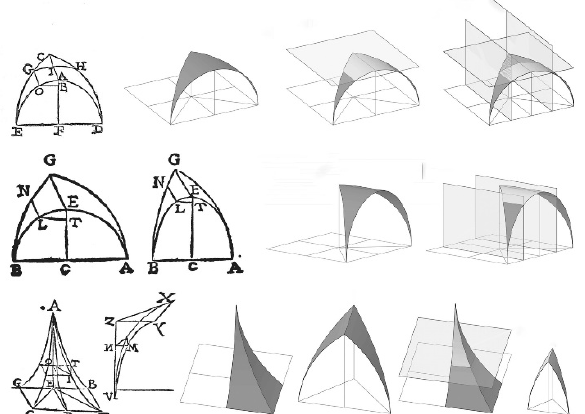
Figure 6. Digital reconstrucrtion of the vault of the main hall of Palazzo Carignano (Modelling: F.